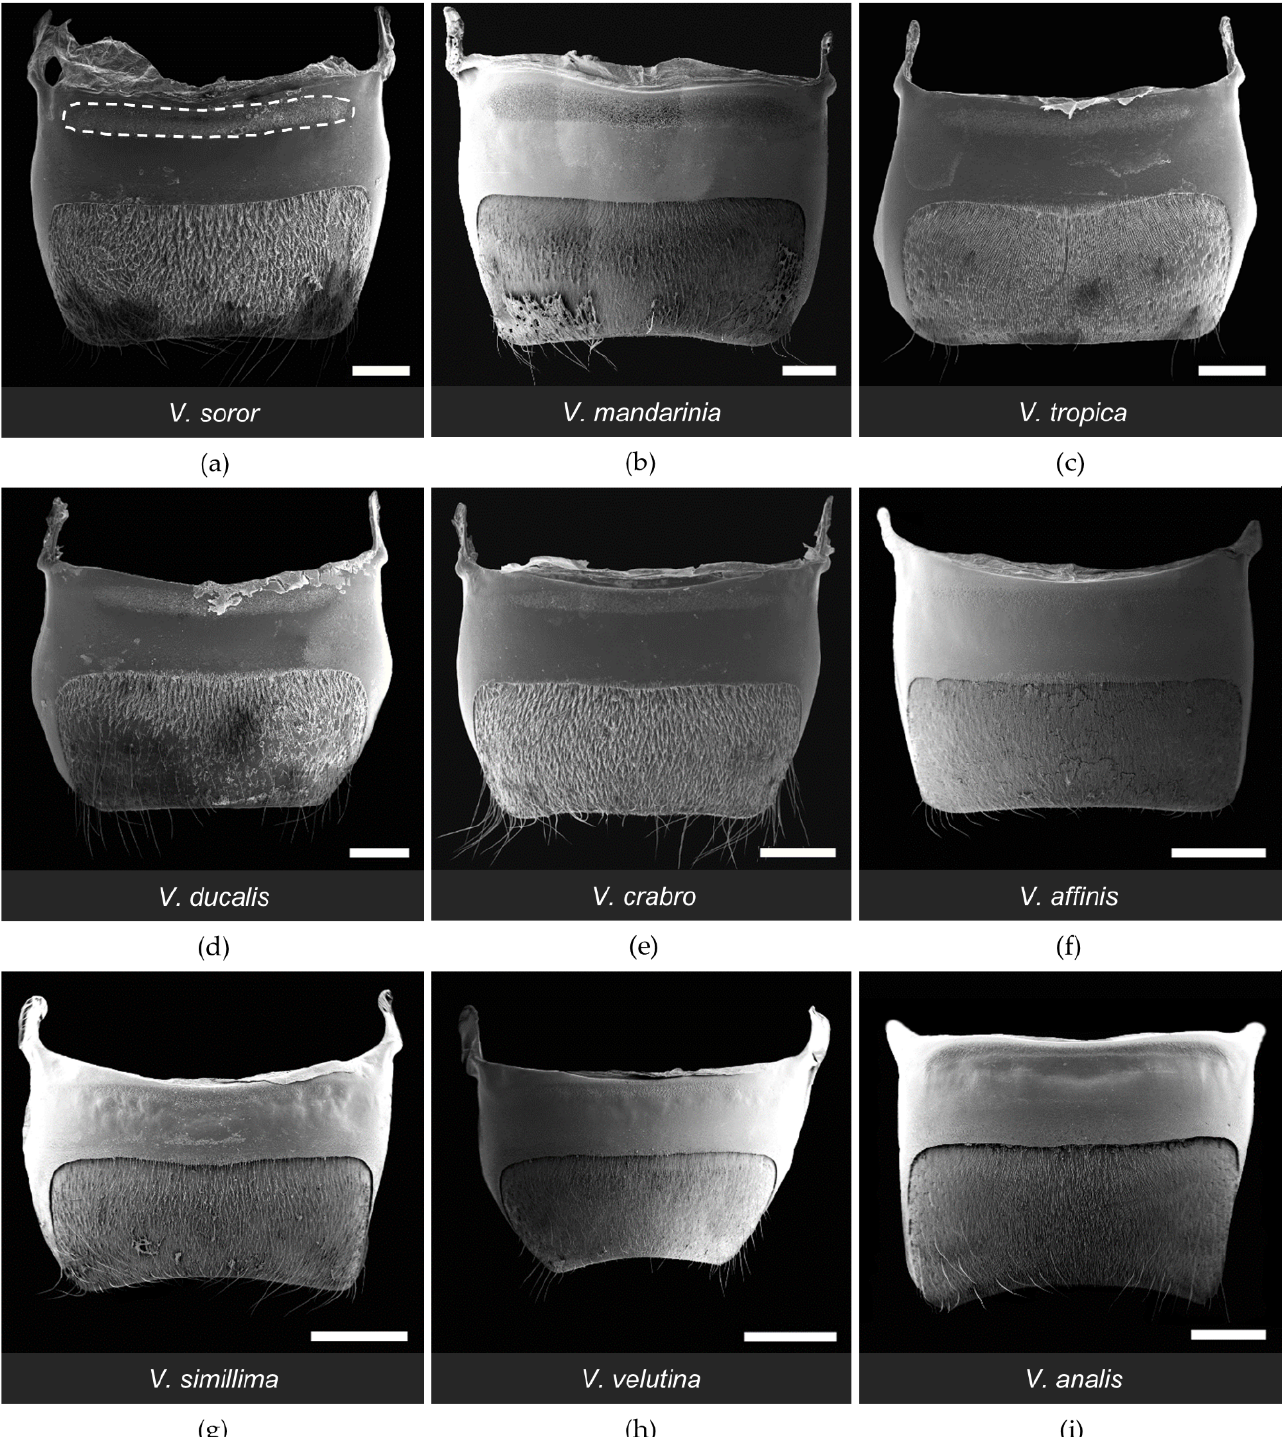
Figure 7. SEM images of the fifth metasomal sternite and the Richards gland of nine Vespa species ( a – i ). Anterior is at the top. Species are presented in the order in which they appear in the phylogeny depicted in Figure 1. The anterior band of pores of the Richards gland is outlined by a dashed white line in ( a ). Composite images (made from images of the same specimen) are shown in ( b , i ). Bars indicate 1 mm for scale.